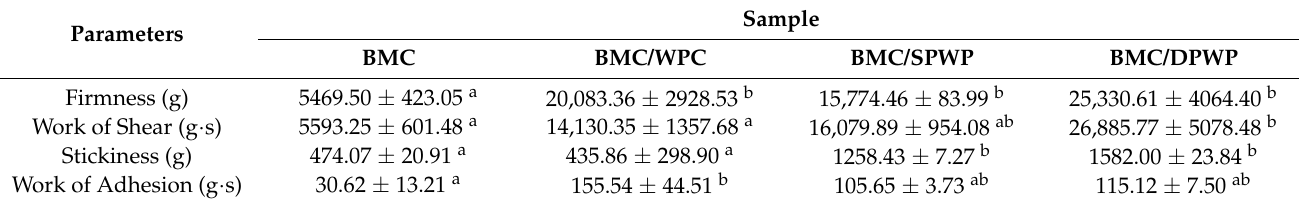
Table 3. Texture of buttermilk cheeses with polymerized whey protein.